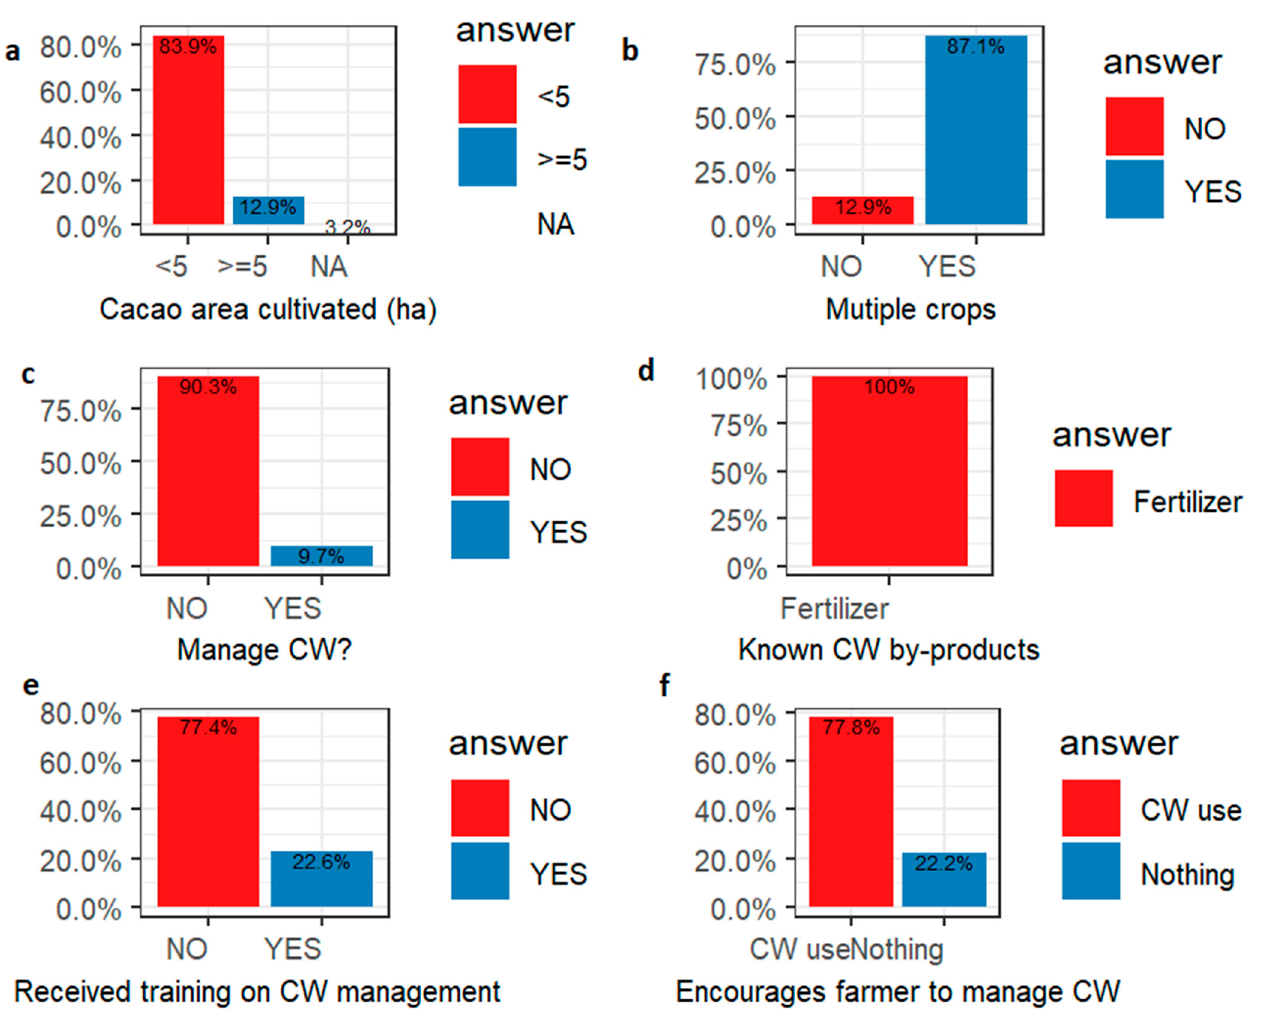
Figure 3. Analytics on data collected through farmers’ surveys and workshops. CW: Cacao waste; NA: Not applicable.